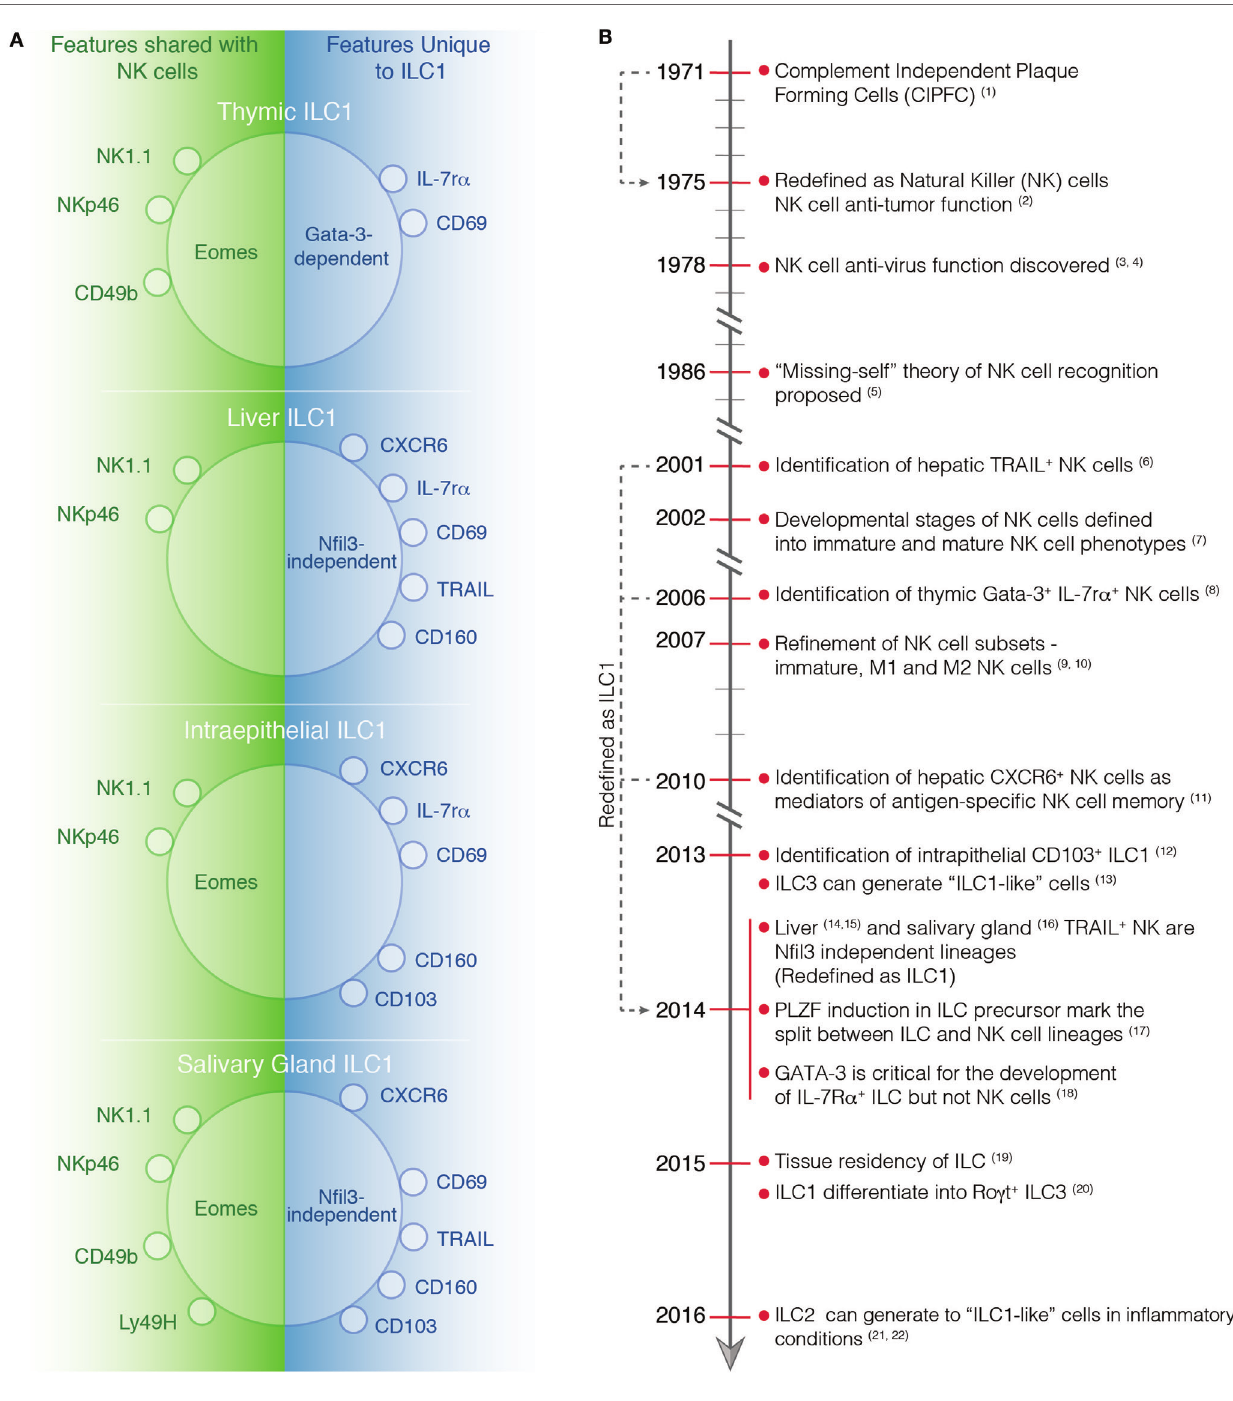
FiGURe 1 | (A) Phenotype of tissue-specific ILC1s and NK cells at steady-state. Characteristic markers of ILC1 in the thymus, liver, intestine, and salivary gland are depicted. On the left, the markers that are expressed by both ILC1s and NK cells are shown while on the right the marker that are only expressed by ILC1s are indicated. (B) Timeline highlighting important discoveries in the identification and characterization of NK cells and ILC1s. (1) Thornthwaite et al. (21). (2) Kiessling et al. (22). (3) Anderson (23). (4) Santoli et al. (24). (5) Karre et al. (25). (6) Takeda et al. (26). (7) Kim et al. (27). (8) Vosshenrich et al. (11). (9) Hayakawa et al. (28). (10) Huntington et al. (29). (11) Paust et al. (30). (12) Fuchs et al. (31). (13) Bernink et al. (32). (14) Seillet et al. (10). (15) Daussy et al. (33). (16) Cortez et al. (34). (17) Constantinides et al. (13). (18) Yagi et al. (35). (19) Gasteiger et al. (6). (20) Bernink et al. (36). (21) Bal et al. (37). (22) Ohne et al. (38).